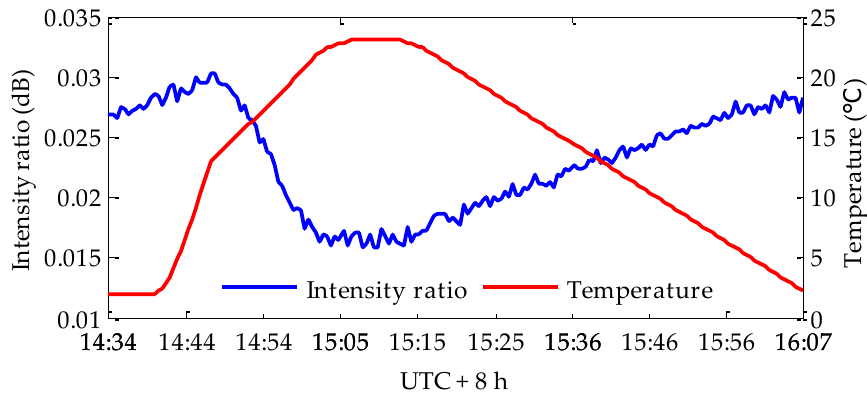
Figure 5. Intensity ratio results with the same experimental setup shown in Figure 4.